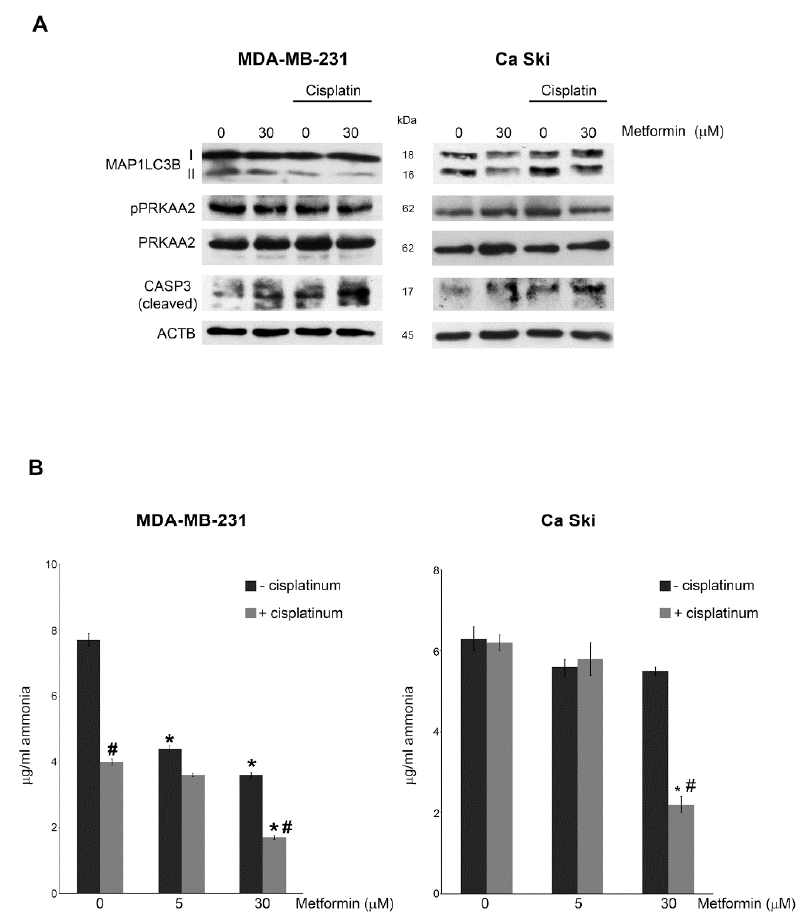
Figure 6. Metformin treatment increases cisplatin effects; ( A ) MDA-MB-231 and Ca Ski cells were either left untreated or treated with metformin or cisplatin alone or metformin in combination with cisplatin for 15 days. At the end of the treatment, cells were processed to obtain whole cell lysates. MAP1LC3B, pPRKAA2 Thr172 , PRKAA2 and CASP3 (cleaved) expression was determined by Western blot. ACTB was used as loading control. Densitometric analysis of the gels was performed as described under Materials and Methods; ( B ) MDA-MB-231 and Ca Ski cells were either left untreated or treated with metformin or cisplatin alone or metformin in combination with cisplatin for 15 days. Ammonia level in the culture medium was measured as indicated in the Material and Methods section. # Significantly different from treatment with metformin alone. All experiments in this figure were repeated three times. * Significantly different from control untreated cells.